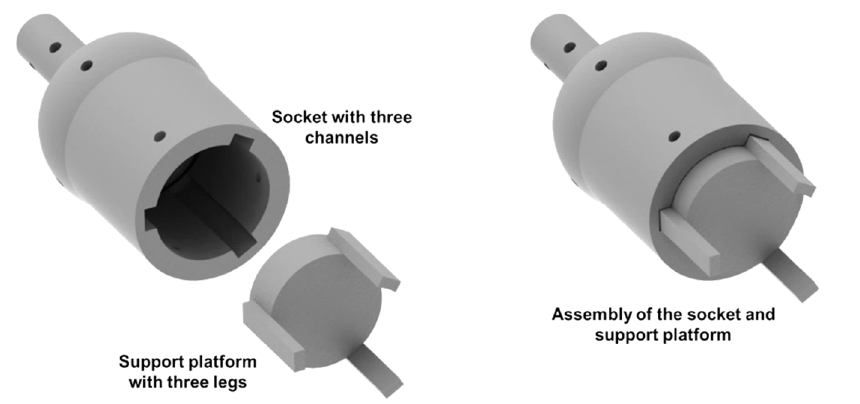
Figure 1. The proposed ball joint with variable stiffness.